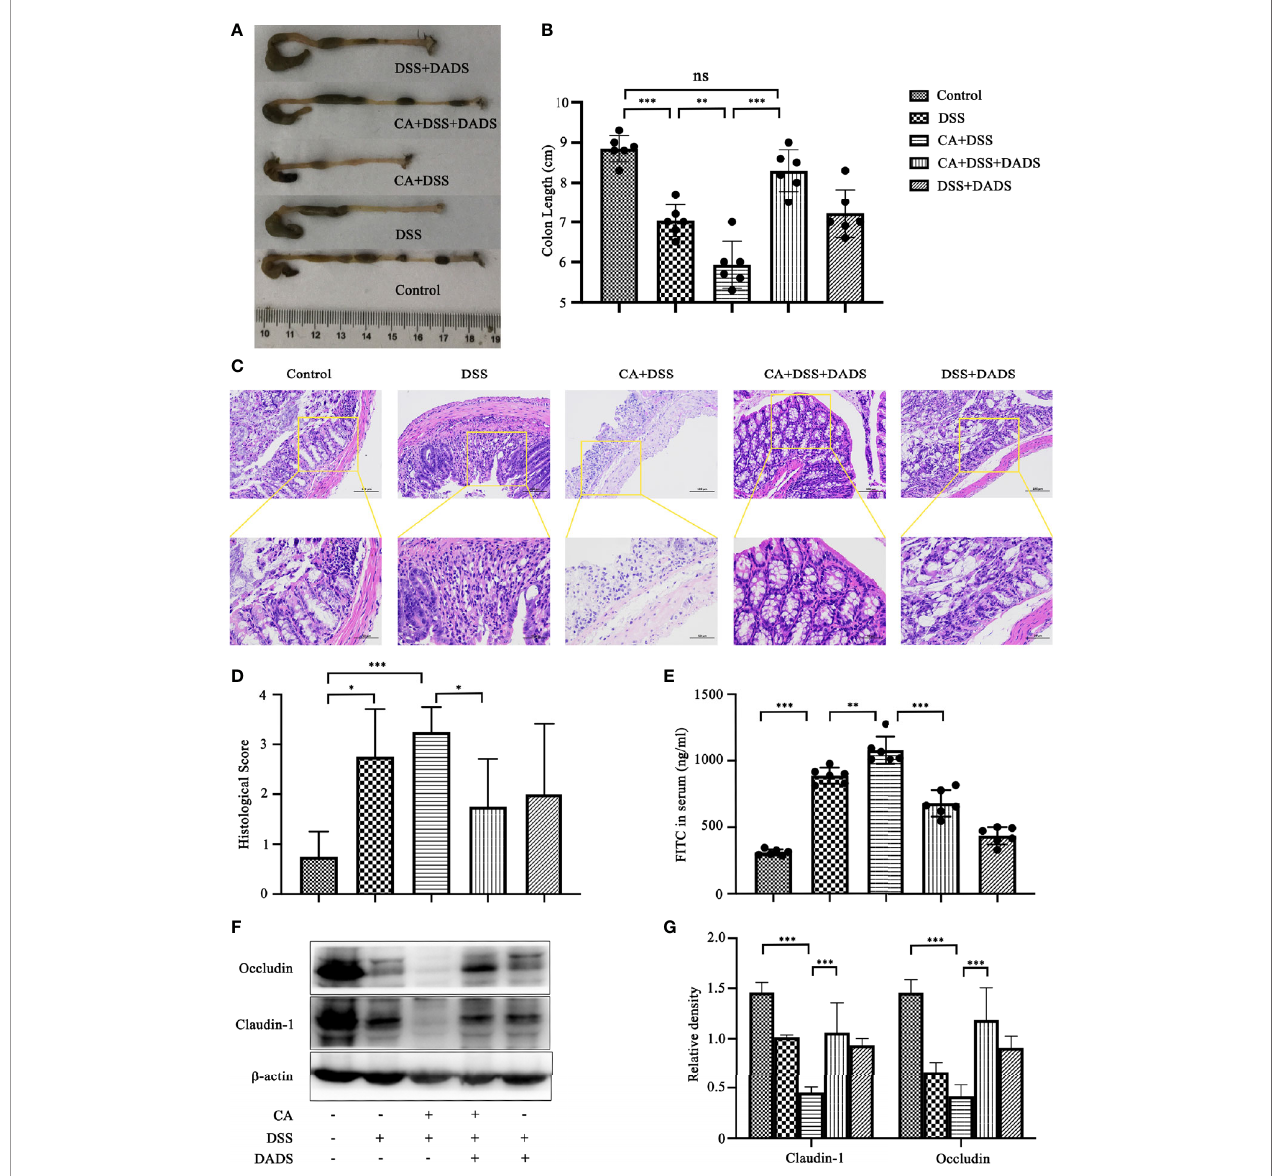
FIGURE 5 | DADS protected the epithelial barrier of mice with C. albicans infection. (A, B) Colon length and relevant statistical analysis. (C, D) H&E staining of colon pathological changes and relevant scores. (E) FITC levels in the serum. (F, G) The levels of tight junction proteins, including Clauding-1 and Occludin. * P < 0.05, ** P < 0.01, and *** P <